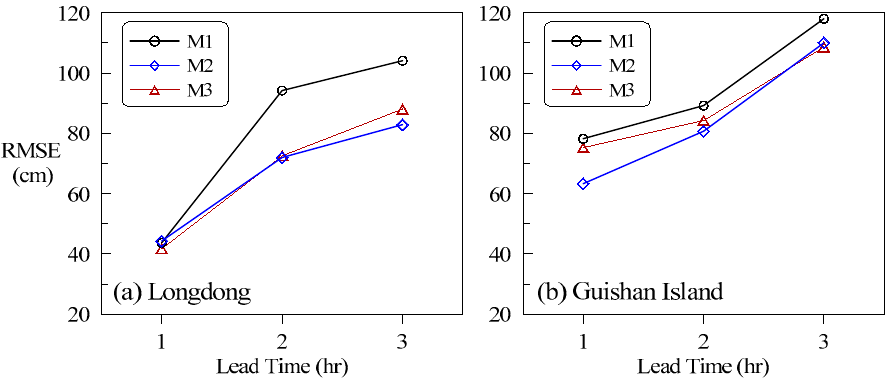
Figure 6. Forecasting performance in terms of RMSEs during the validation phase for ( a ) Longdong